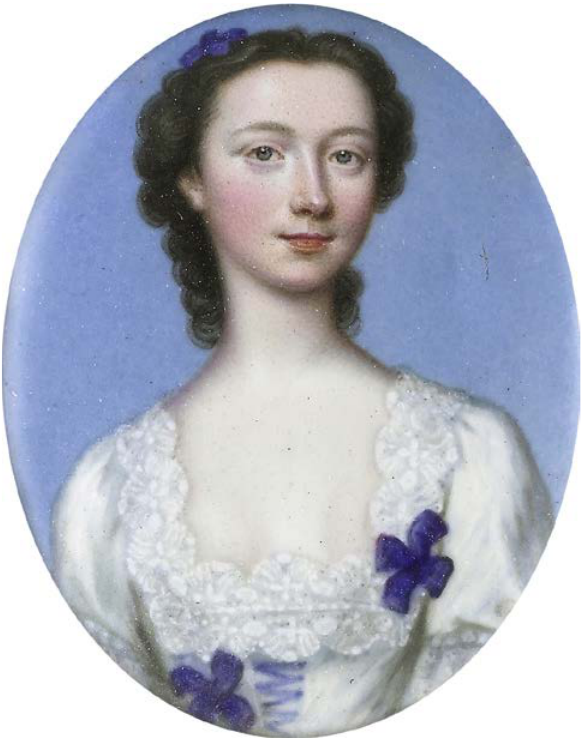
Figure 1 - Catherine Talbot by Christian Friedrich Zincke (1683/4-1767) [n.d.] ©